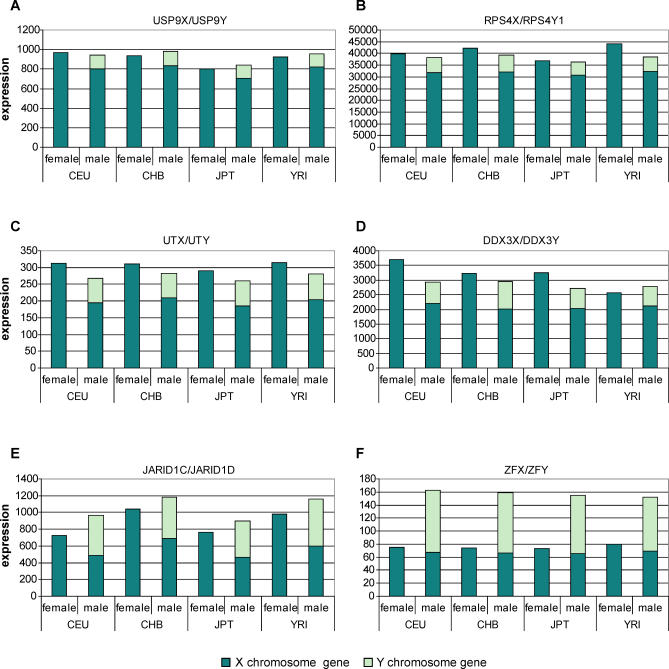
Evidence That Expression of the Y-linked Copy of XY Gene Pairs Can Maintain Dosage Compensation(A–F) Stacked bars show the cumulative expression of X and Y gametologues in males alongside expression from the X chromosomes in females. Note that the y-axis is a linear scale.